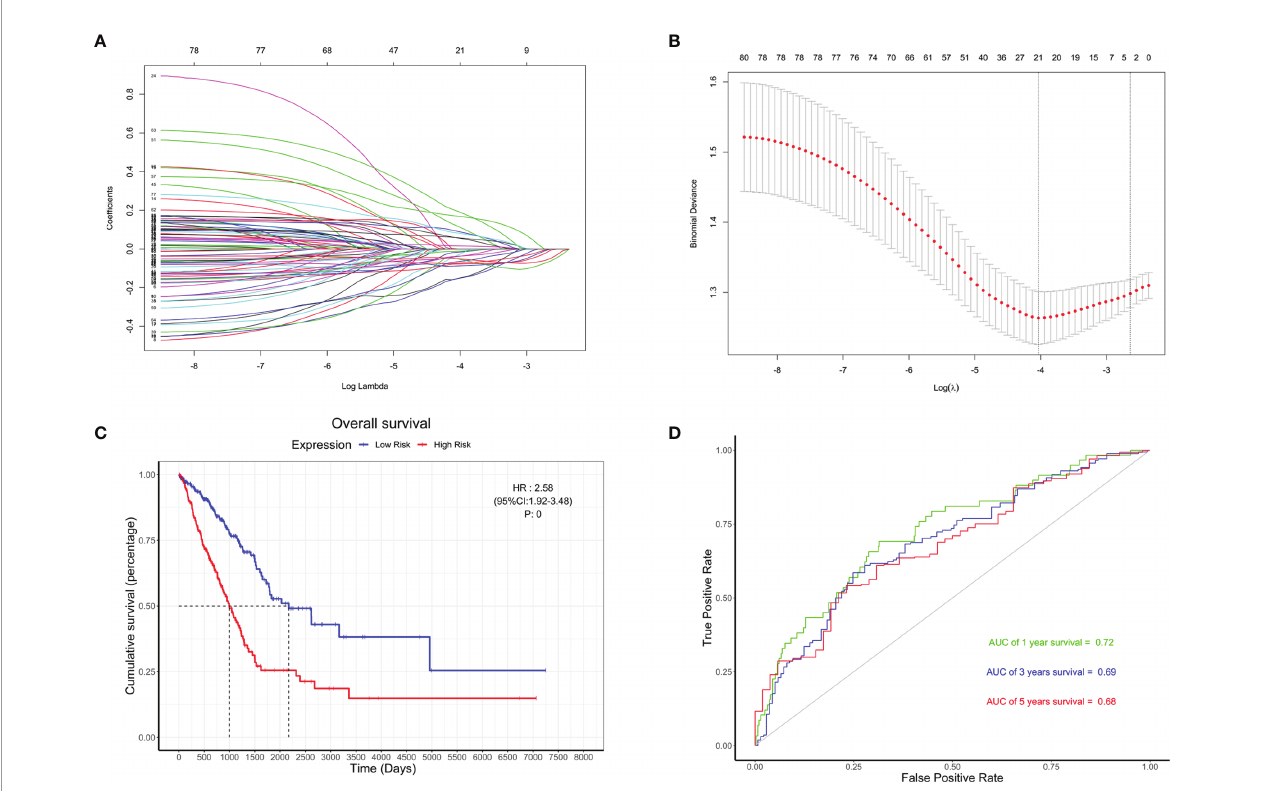
FIGURE 7 | The re-establishment of the risk model and the evaluation of its prognostic value. (A) Distribution of least absolute shrinkage and selection operator (LASSO) coef fi cients for BMP5 and 79 hub genes. (B) Partial likelihood deviation of the LASSO coef fi cient distribution. Vertical dashed lines indicate lambda.min (left) and lambda.1se (right). (C) The Kaplan – Meier curve of patients with low risk and high risk based on the re-established risk model in TCGA-LUAD (HR: 2.58, 95% CI: 1.92 – 3.46, p : 0). (D) The receiver operating characteristic (ROC) curve for the prognostic value of the re-established risk model (AUC of 1-year survival: 0.72, 3-year survival: 0.69, 5-year survival: